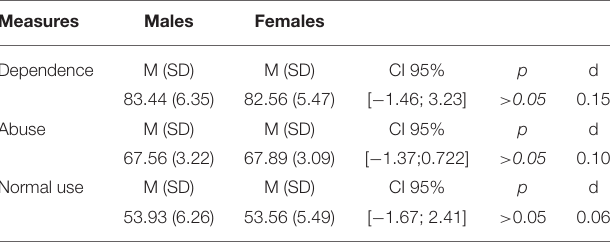
TABLE 1 | Differences in the level of Internet addiction with respect to gender of participants. Measures